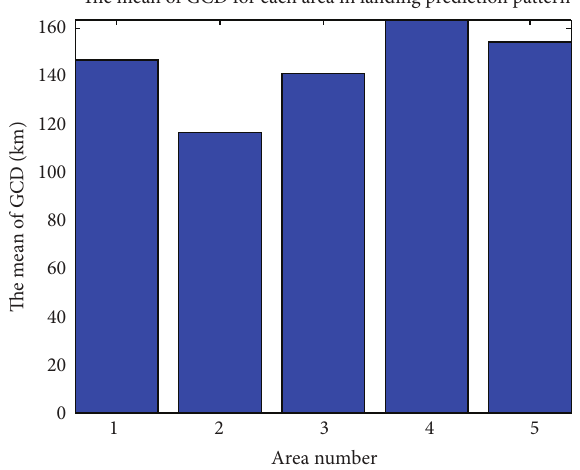
Figure 13: The mean of GCD for each area in landing prediction pattern.